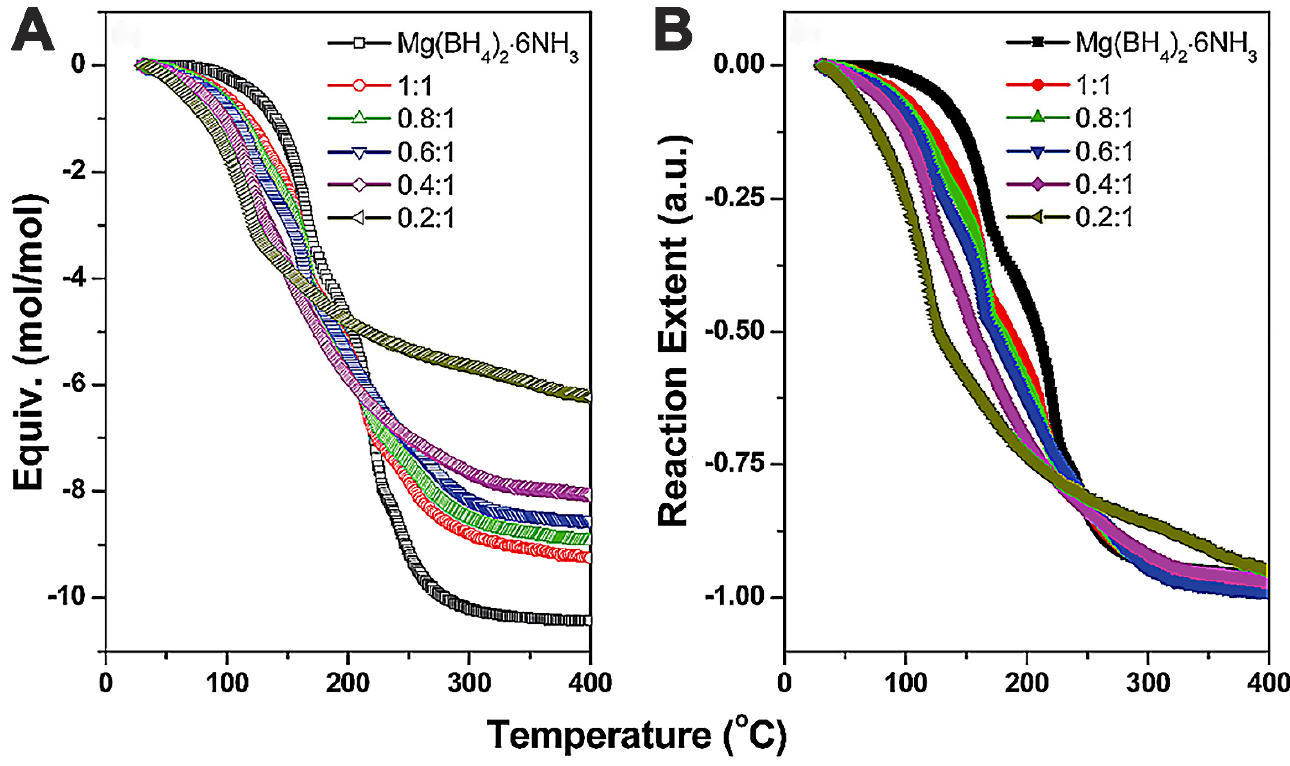
Figure 13. Volumetric release ( A ) and reaction extent ( B ) curves of the bulk Mg(BH 4 ) 2 · 6NH 3 and Mg(BH 4 ) 2· 6NH 3 @AC nanocomposites. Figure is reprinted with permission from [256] .